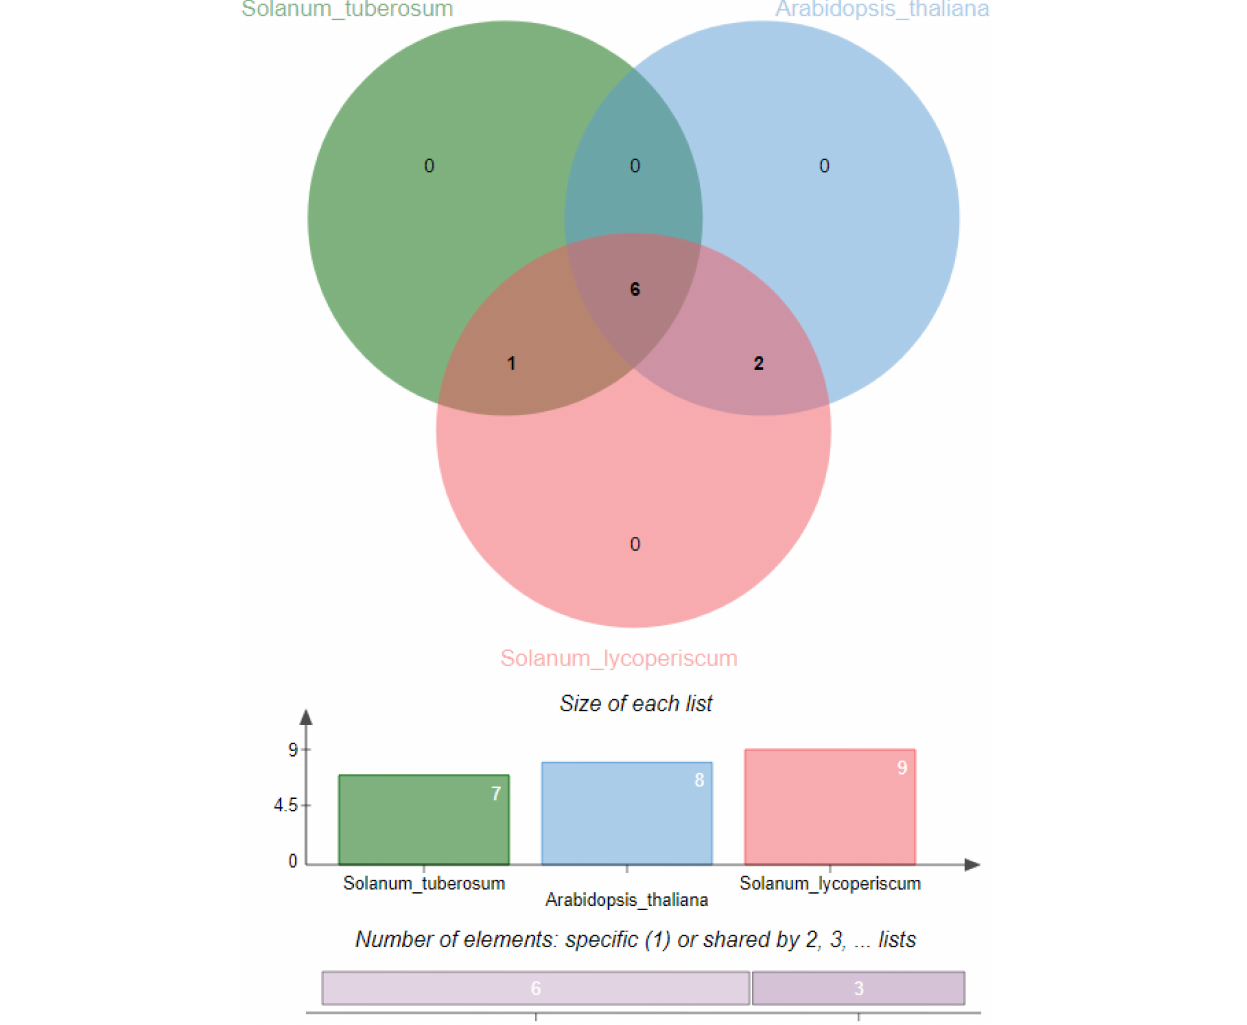
Frontiers in Plant Science |